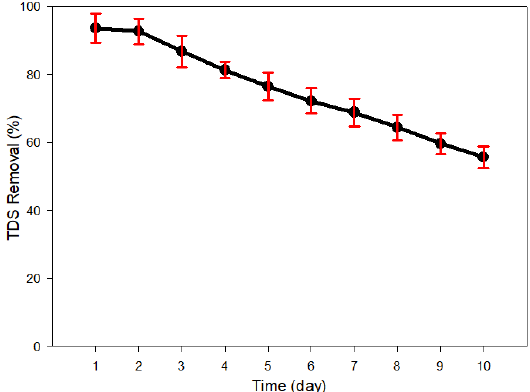
Figure 10. The variation of TDS removal rate over 10 days of 24 h per day operation. The average